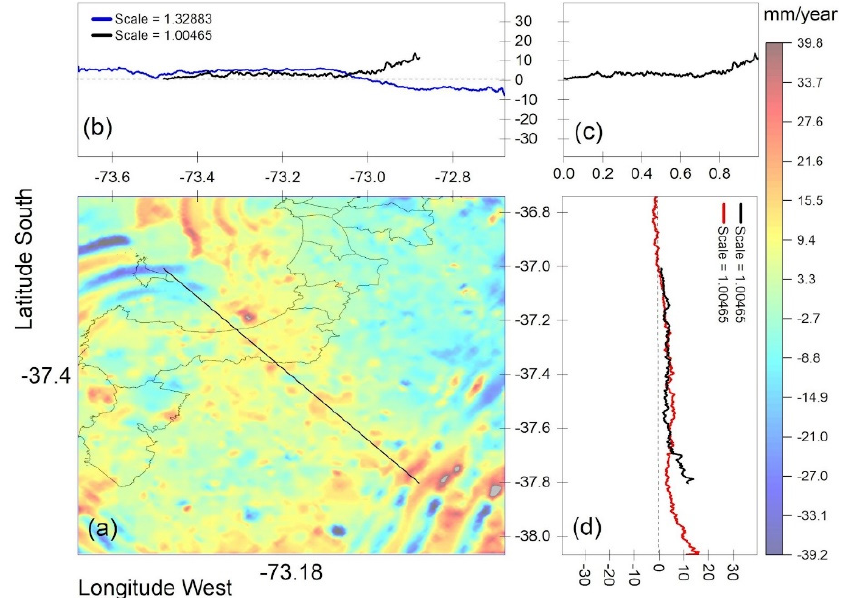
Figure 8. ( a ) Consolidate graph of tendency behavior by geographic position in the study zone, ( b ) horizontal, ( c ) arbitrary (represented by the black line), and ( d ) vertical displacement.